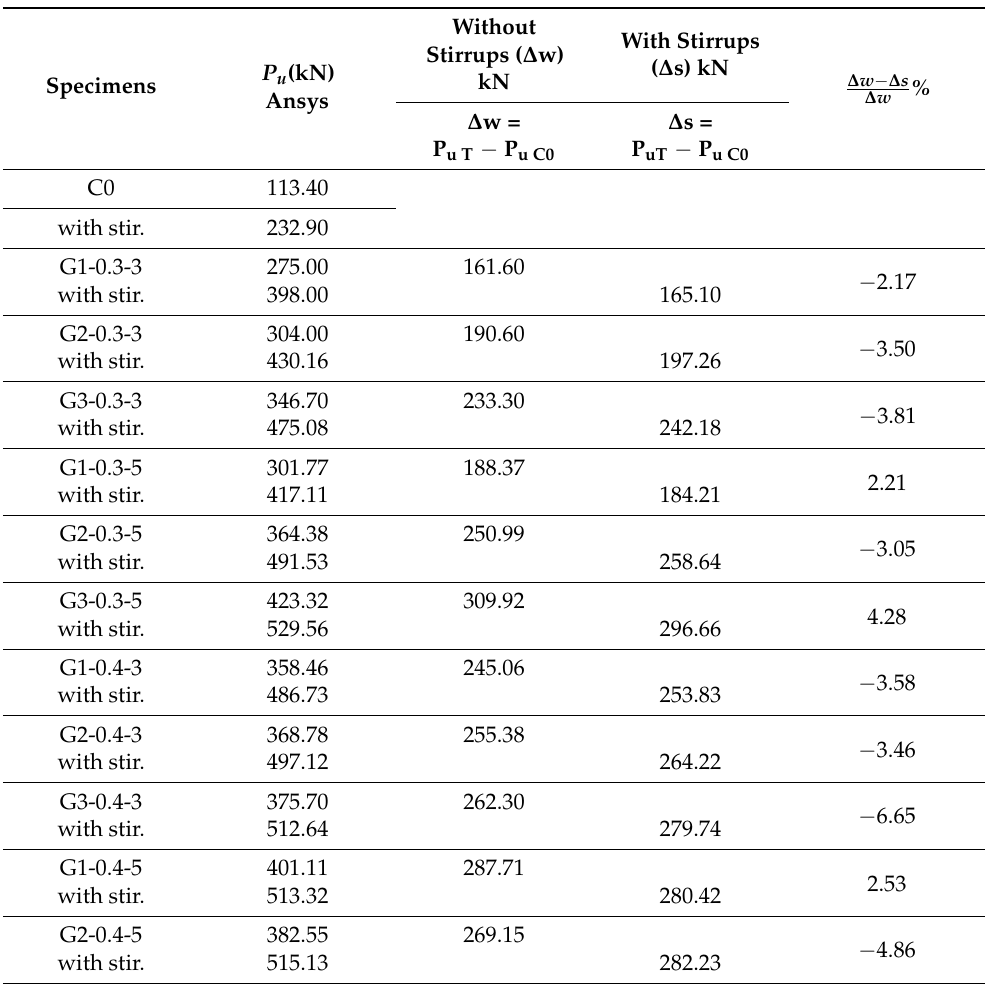
Figure 12. Specimen details and arrangement of reinforcement (all dimensions in mm). ( a ) Specimen with web stirrups within shear zone. ( b ) Specimen without web stirrups within shear zone. Table 5. The output results for the analyzed